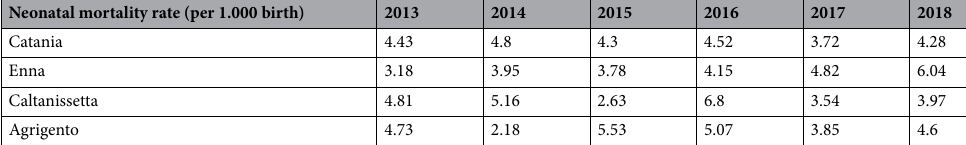
Neonatal mortality rate (per 1.000 birth)